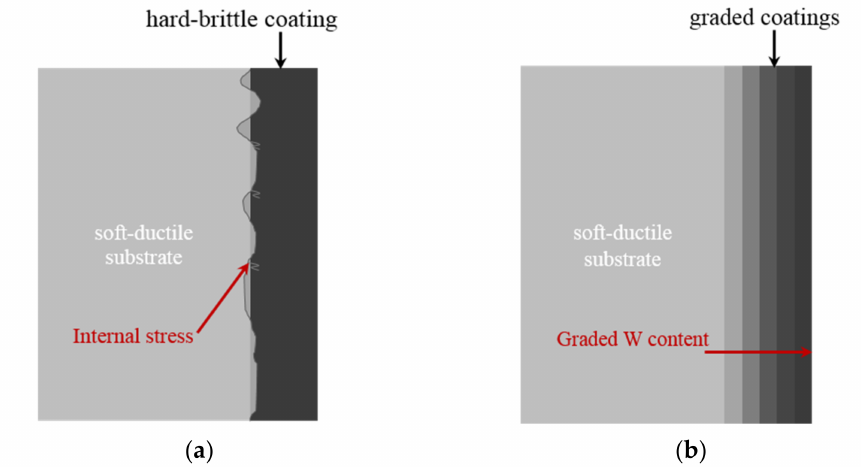
Figure 1. The bond between soft-ductile substrate and hard-brittle coating: ( a ) the internal stress of alloy coating; ( b ) superior bond of graded